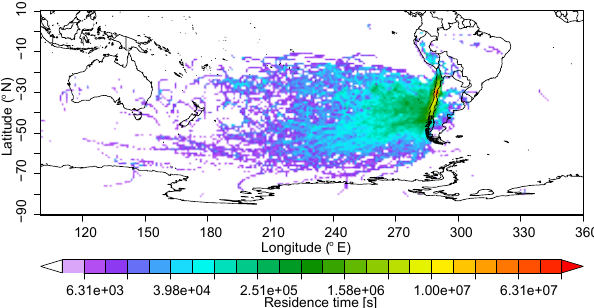
Figure 2. FLEXTRA trajectory footprint from April 2013 to De- cember 2015, originating at El Tololo (TLL), 370m above model topography. Color indicates the total residence time of air parcels, summed up over the time period. TLL is marked with a black